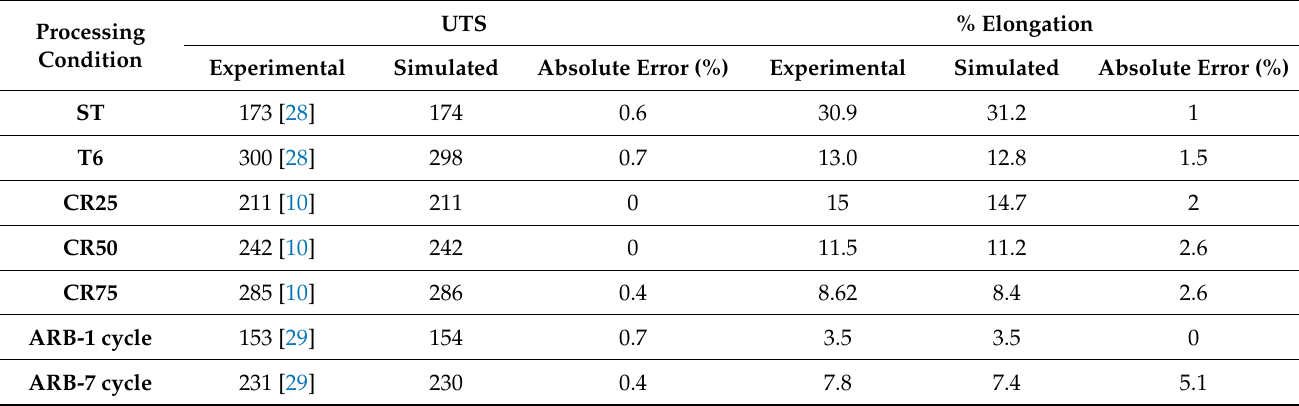
Table 2. Comparison of experimental and simulated tensile